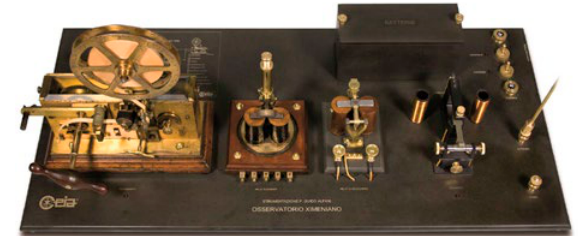
Figure 5. Radio receiver built in 1923 according to the model of Marconi’s receiver dating back to 1895. 4 A part from the battery box, all the other components like the coherer (right lower part, near to the antenna) are